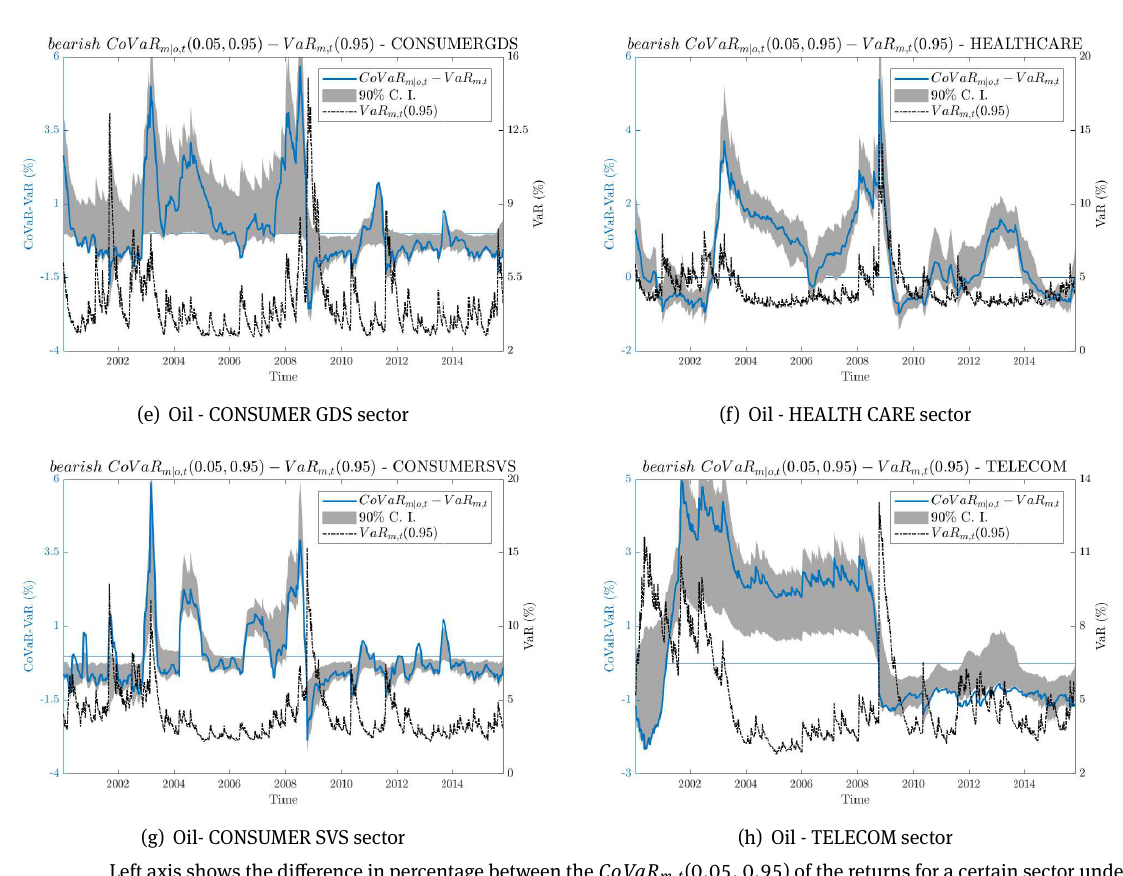
extreme downward movement in oil prices, i.e. below its 5-th quantile, and its unconditional VaR shows this difference given the best copula mixture according to Table 6. Grey area indicates the 90% confidence interval of the difference between CoVaR (0.05, 0.95) and VaR (0.95) following a Monte Carlo technique explained in Appendix C. The m , t m | o , t right axes shows the value of the VaR (0.95) in percentage. The dash-dotted black line indicate the VaR level over m , t